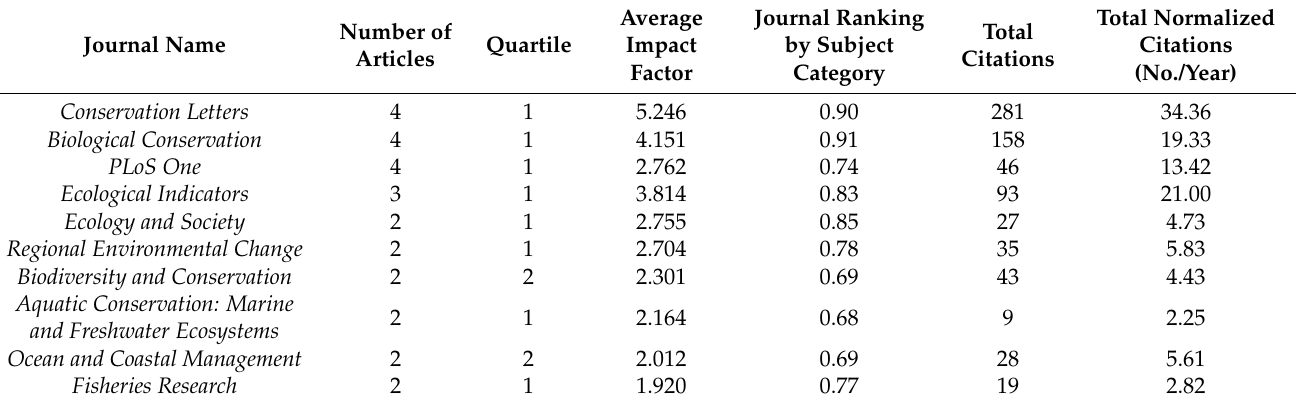
Table 2. Top 10 journals publishing articles about the ecological effectiveness of protected